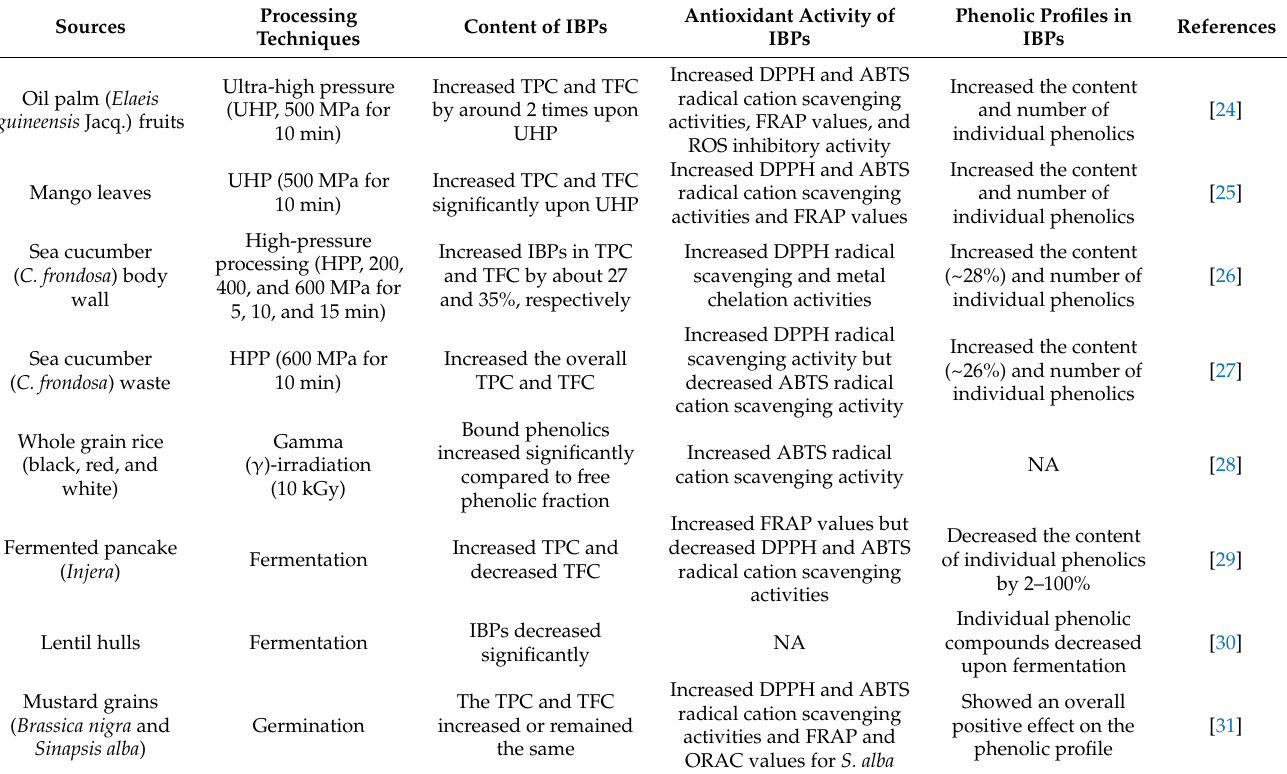
Table 1. Release of insoluble-bound phenolics from cell wall matrix upon